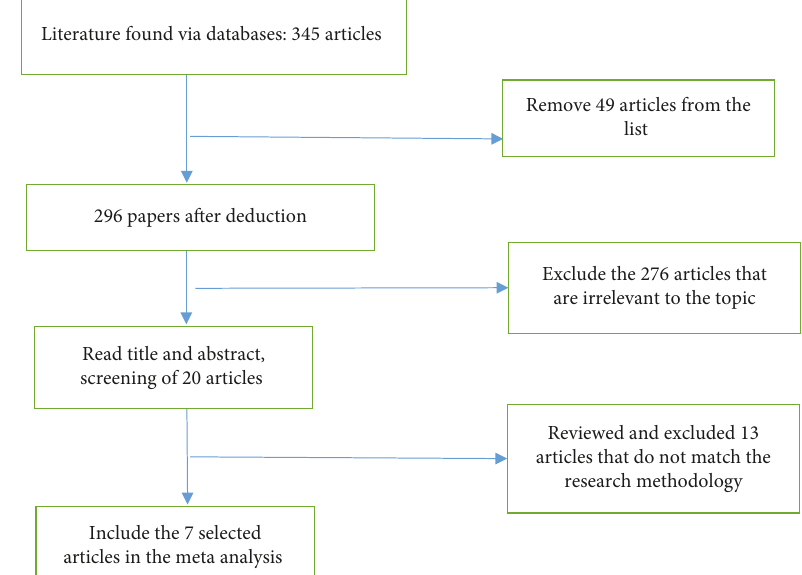
Figure 1: Literature screening process.